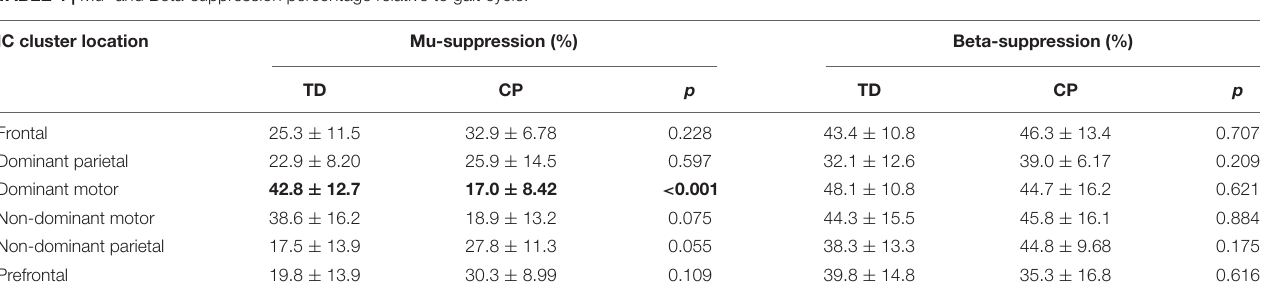
TABLE 4 | Mu- and Beta-suppression percentage relative to gait